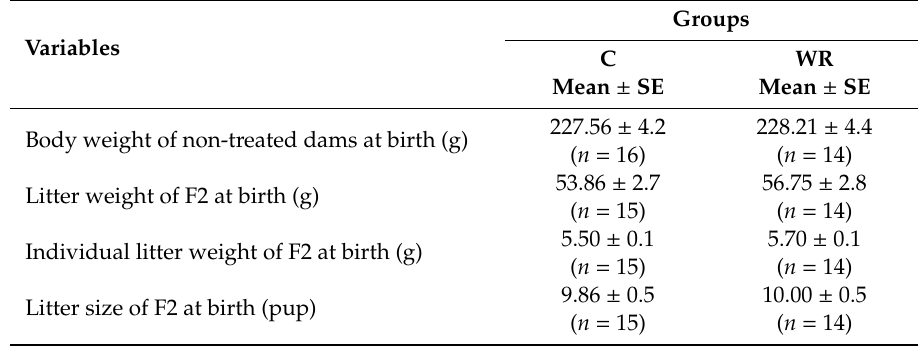
Groups C WR Mean ± SE Mean ± SE 227.56 ±